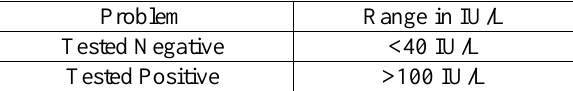
Table 6. Investigation ranges of skin problems.